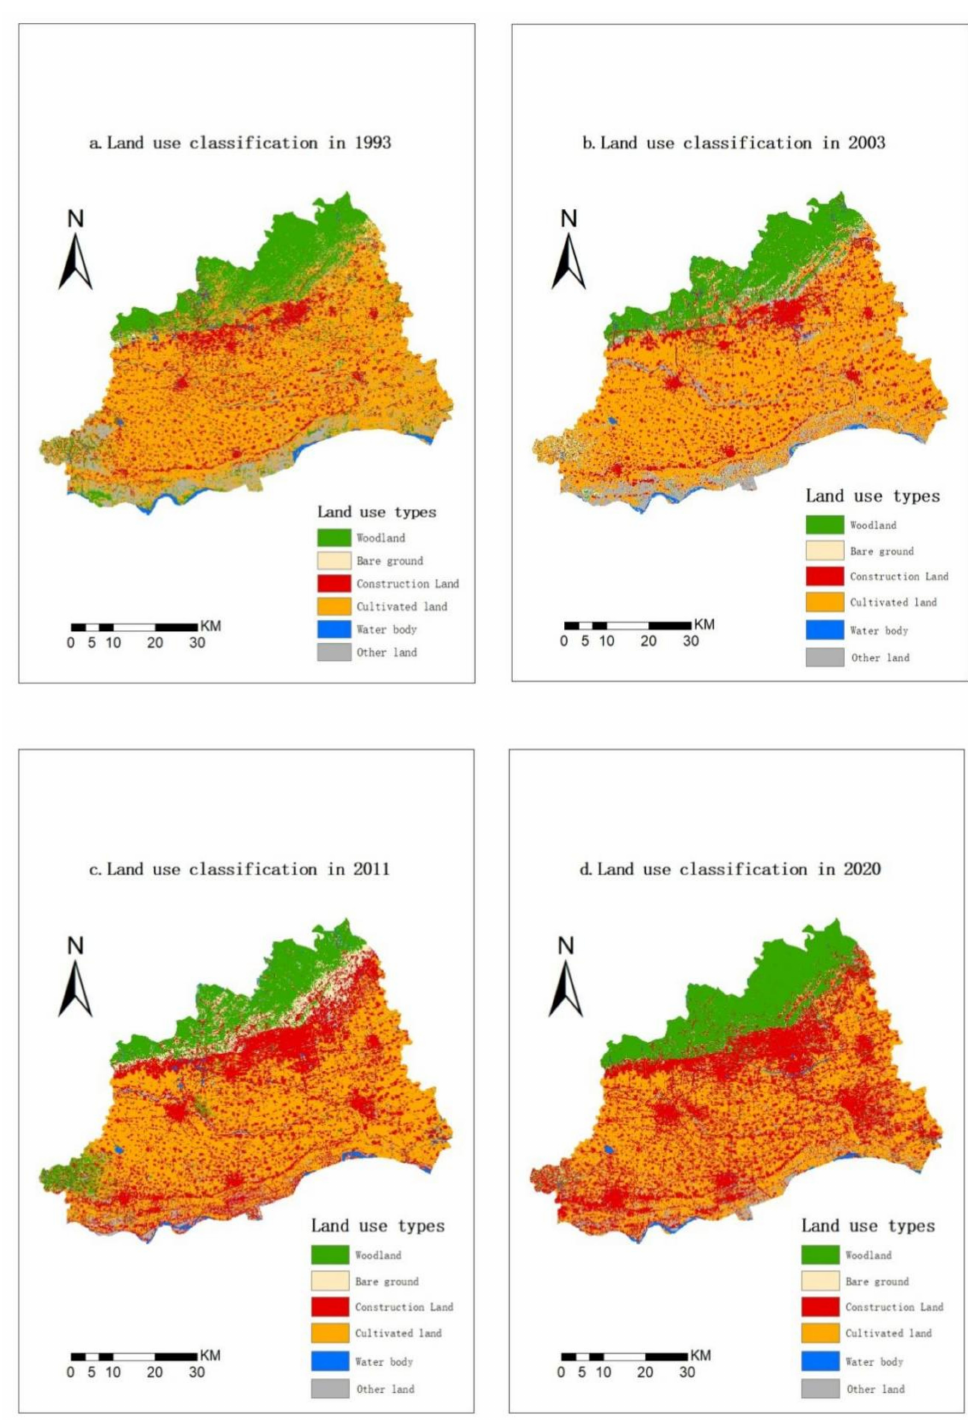
Figure 6. Land use maps of Jiaozuo